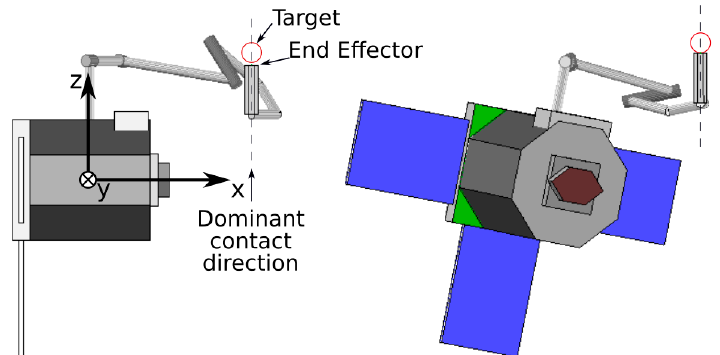
Figure 3. The simulated satellite robot and target body in the initial position ( left ), and during contact ( right ). The line of dominant direction of the final approach is shown by the dashed line.